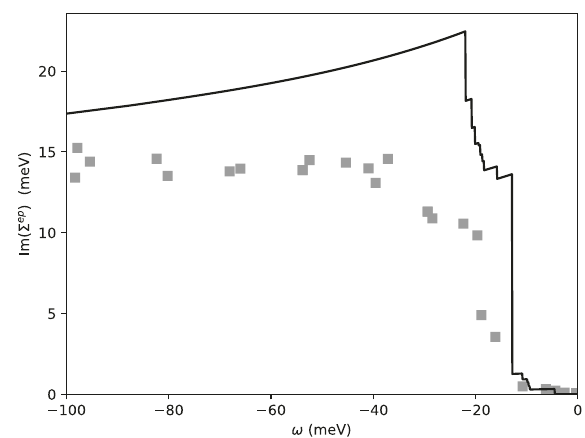
Fig. 2 Imaginary part of the self-energy for MAPbI 3 . Imaginary part of the expectation value of the phononic part of the self-energy as a function of the hole energy (w.r.t to the energy of the VBM) for orthorhombic MAPbI 3 at the temperature T = 1 K. Solid line: results with this method. Gray squares: results from Ref. 11 .